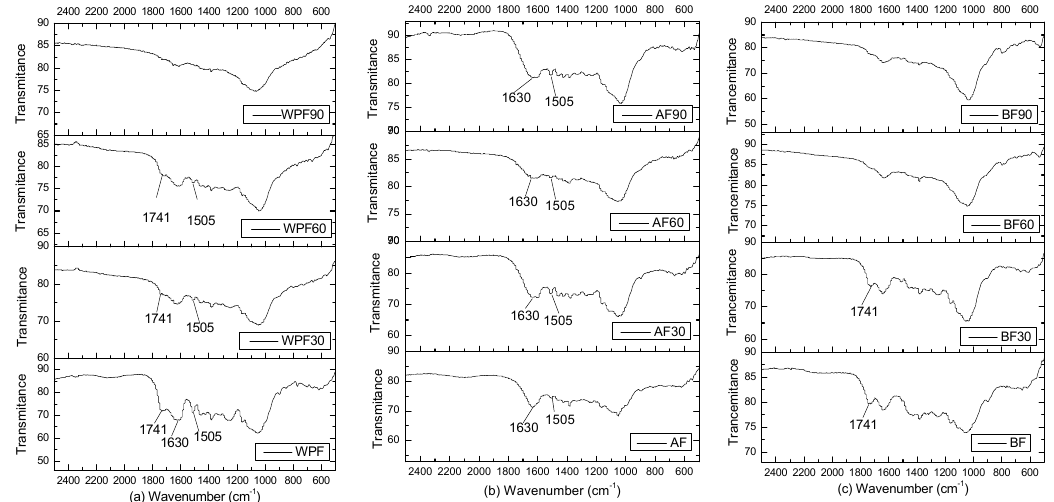
Figure 2. Fourier Transforms Infrared (FT-IR) spectra of ( a ) windmill palm fiber ( b ) alkali-treated fiber and ( c ) bleached fiber before and after biodegradation.